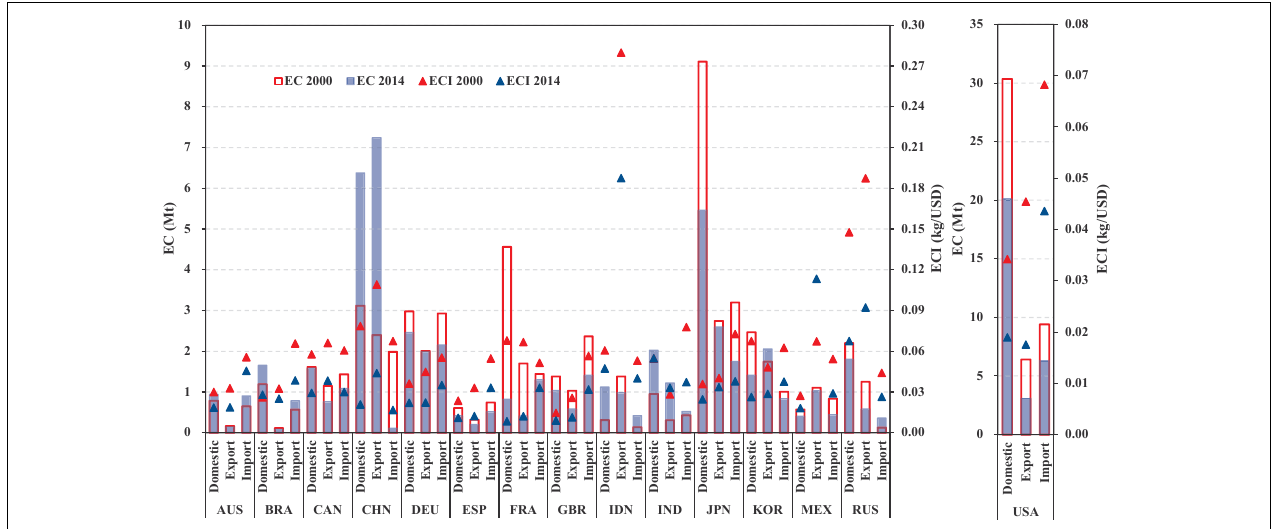
FIGURE 1 | The ICT’s embodied carbon emissions and intensities of major countries in 2000 and 2014. Note: EC represents the embodied carbon emissions, ECI represents the embodied carbon emission